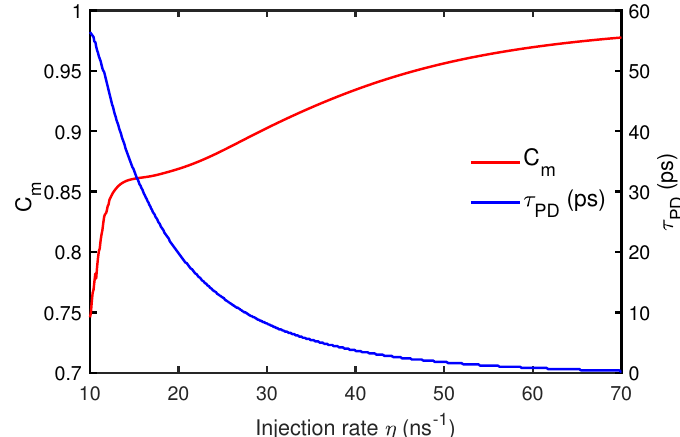
Figure 6. Transmitter-receiver maximum correlation coefficient C m (red trace) and the associated intra-cavity propagation delay τ PD (blue trace) as a function of injection rate for keeping ∆ f = 0, κ = 9 ns − 1 , τ ext = 10 ns, and τ f =